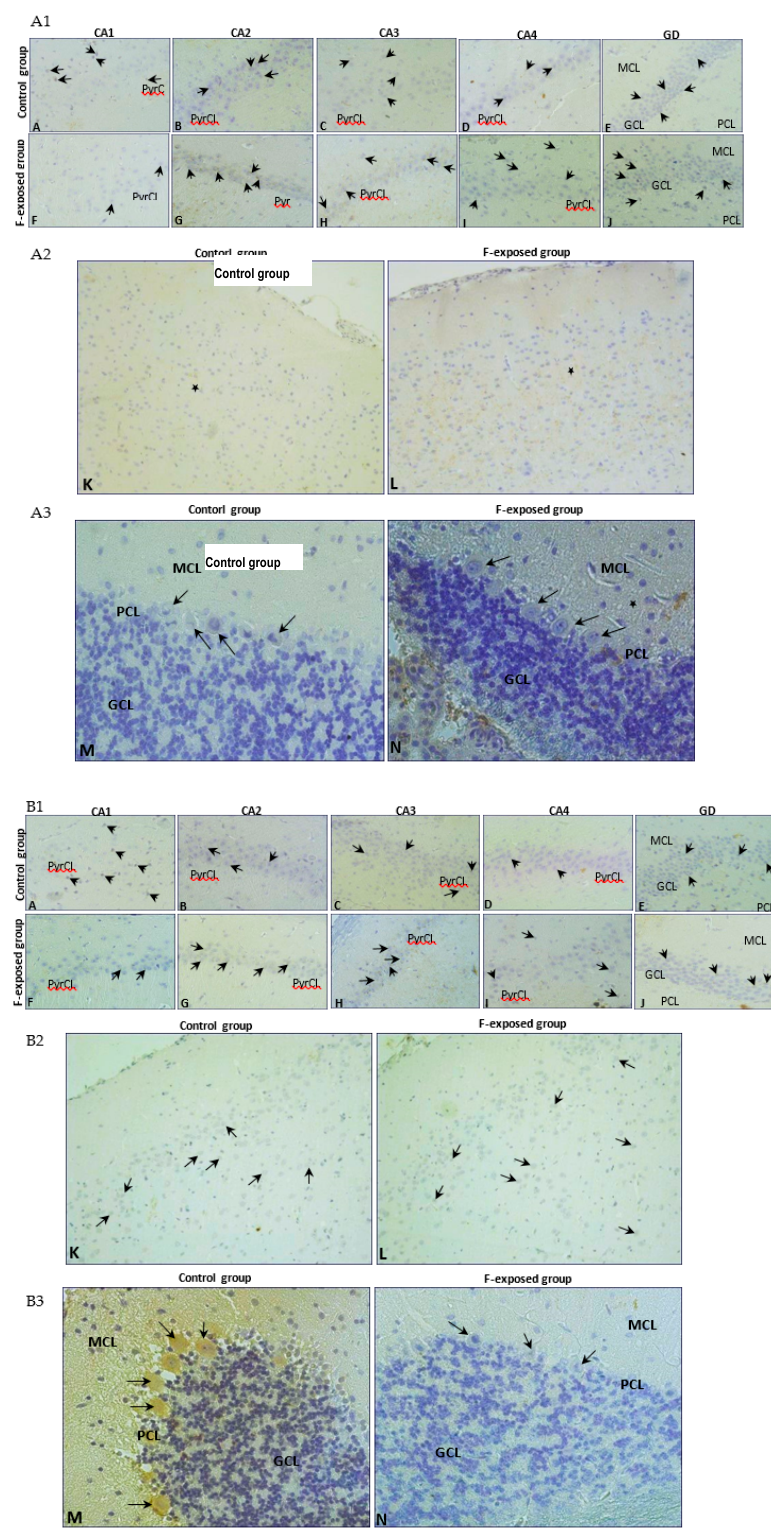
Figure 2. Immunolocalization of MMP2 ( A1 – A3 ) and MMP9 ( B1 – B3 ) in analyzed brain structures (hippocampus, objective magnification × 40 ( A1 , B1 ); prefrontal cortex, objective magnification × 20 ( A2 , B2 ); cerebellum, objective magnification × 20 ( A3 , B3 )). Hippocampus (CA1–CA4): area of cornu ammonis (CA); gyrus dentate (GD); pyramidal cell layer (PyrCL); granular cell layer (GCL); polymorphic cell layer (PCL); molecular cell layer